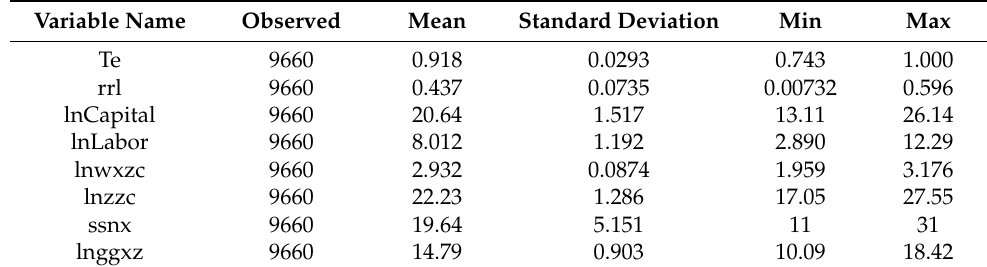
Table 2. Descriptive statistics of relevant variables.